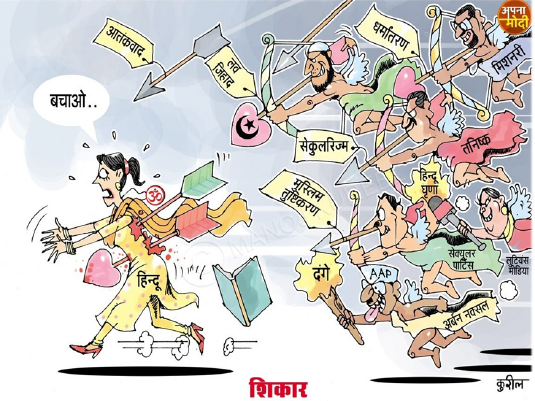
Figure 10. Memes and caricatures circulated on Facebook depicting helpless Hindu girls trapped by Muslims. Save Hindu girls from Muslims ( top ) is a popular trope used to alert Hindus from forming friendships or relations with Muslims. Cartoon ( bottom ) shows Hindu.